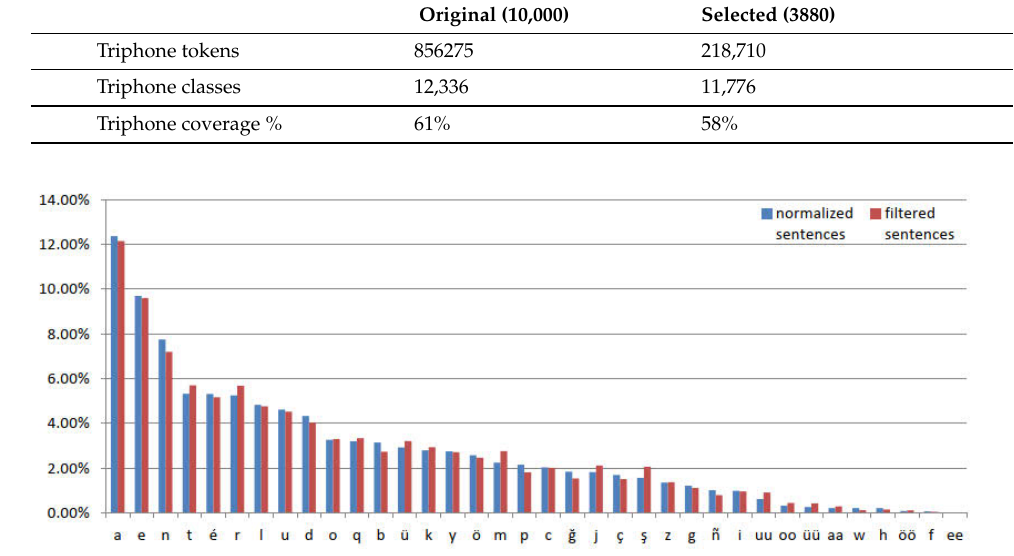
Figure 1. The phone distribution before (normalized sentences) and after (filtered sentences) the selection process.